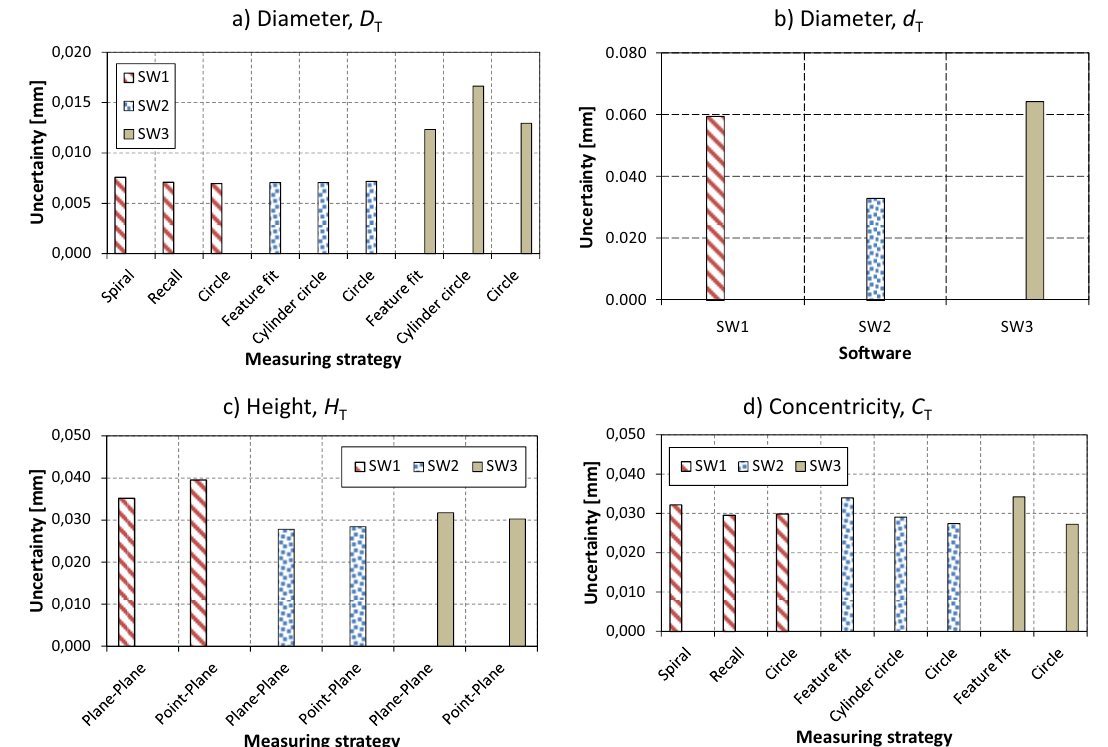
Fig. 7. Expanded uncertainties at 95% confidence level for measurements performed on the toggle. Measurement uncertainties are calculated according to equation